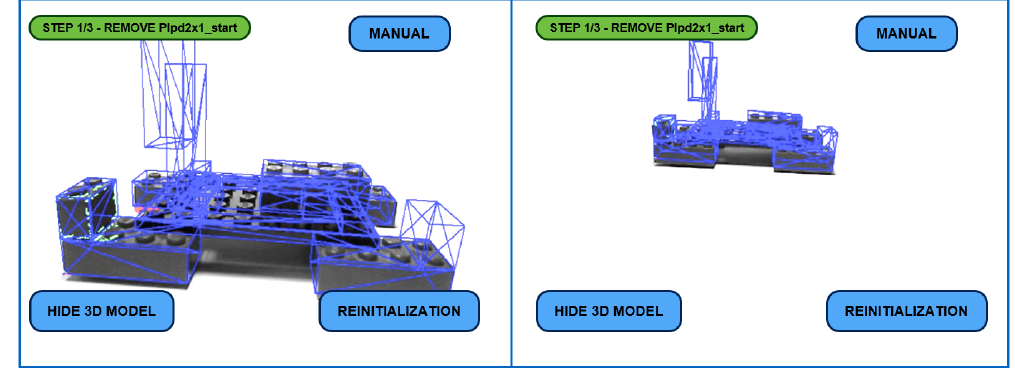
Figure 12. Object tracking when motion occours.